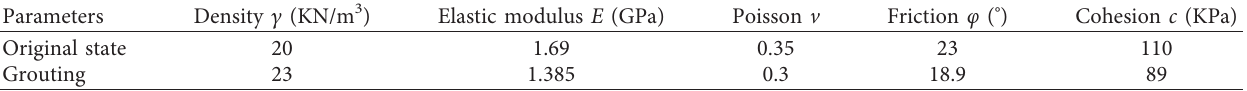
Figure 2: Failure characteristics of Muzhailing tunnel. (a) Serious deformation of arch frame. (b) Large deformation of the left arch shoulder. Table 1: Physical and mechanical parameters of tunnel surrounding rock.